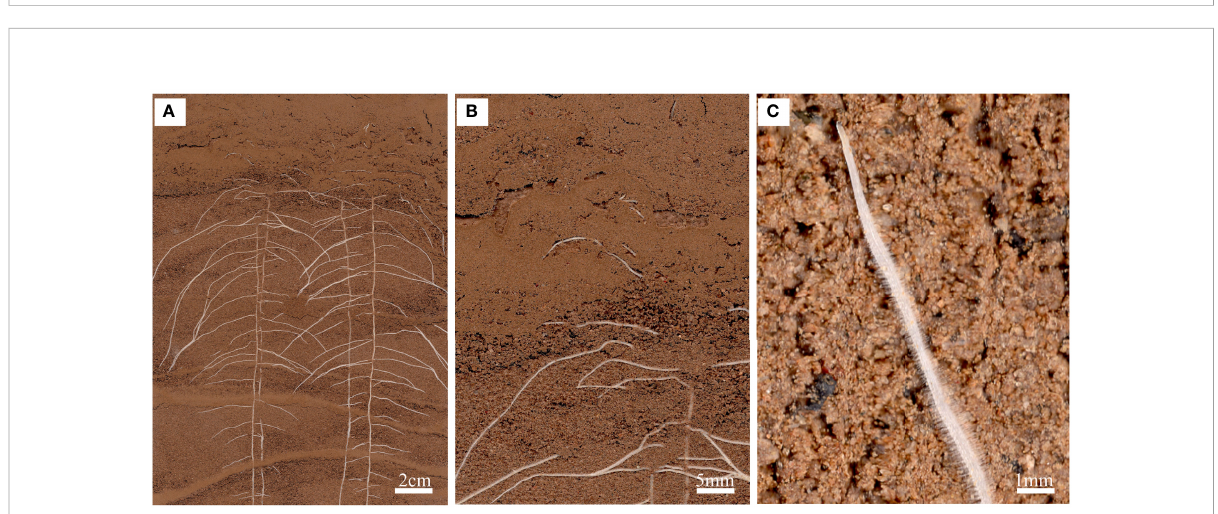
FIGURE 3 An in situ root phenotype with a cluttered scene. (A) A sample input image of the root system of a cotton seedling growing on RhizoPot. (B) The scene with cluttered colors represents the dif fi culty associated with image segmentation. (C) Visible root hairs and root